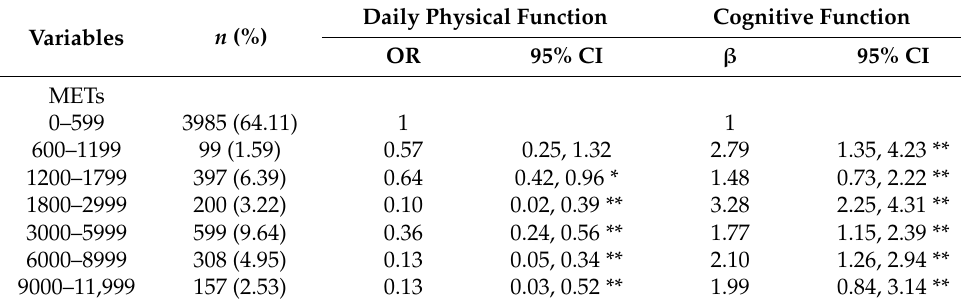
Table 3. Associations between Mets and the daily physical activity ability and cognitive function of patients with heart